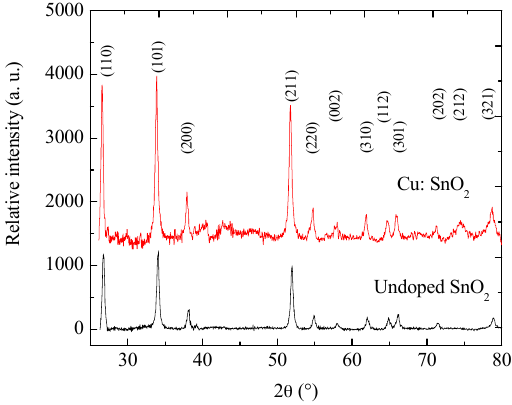
Figure 2. XRD patterns of pure and Cu-incorporated SnO 2 powders.